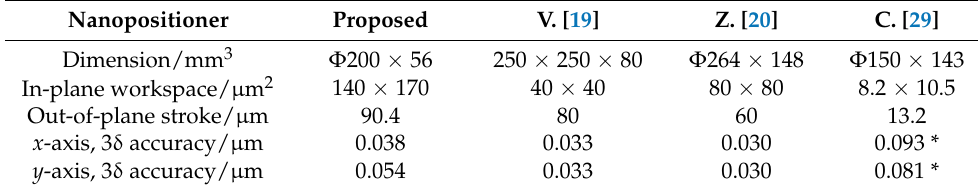
Table 2. Comparison of key performance indexes of selected spatial